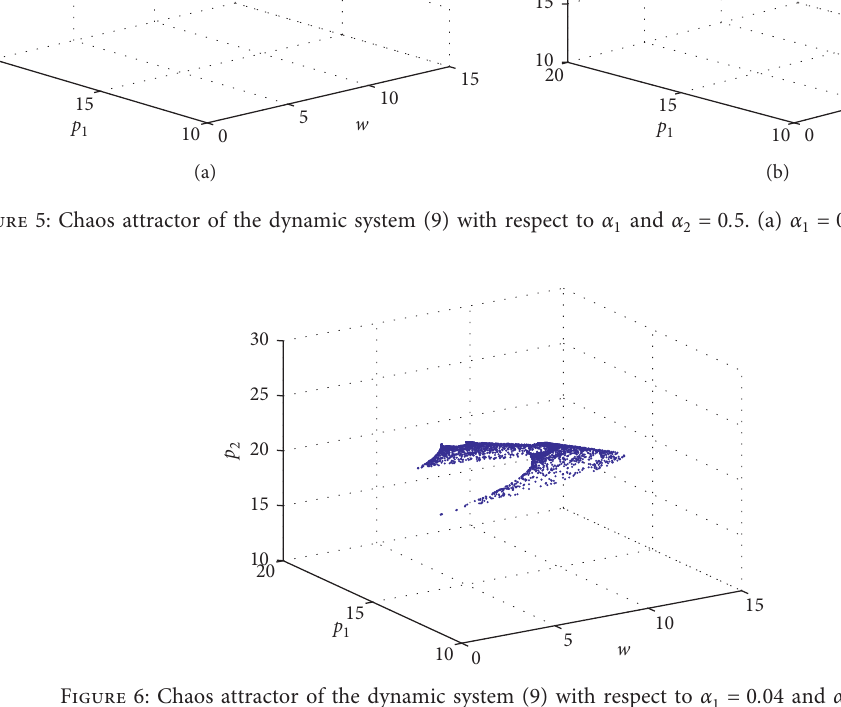
� 0 . 04 and α � 1 . 05. 1 2